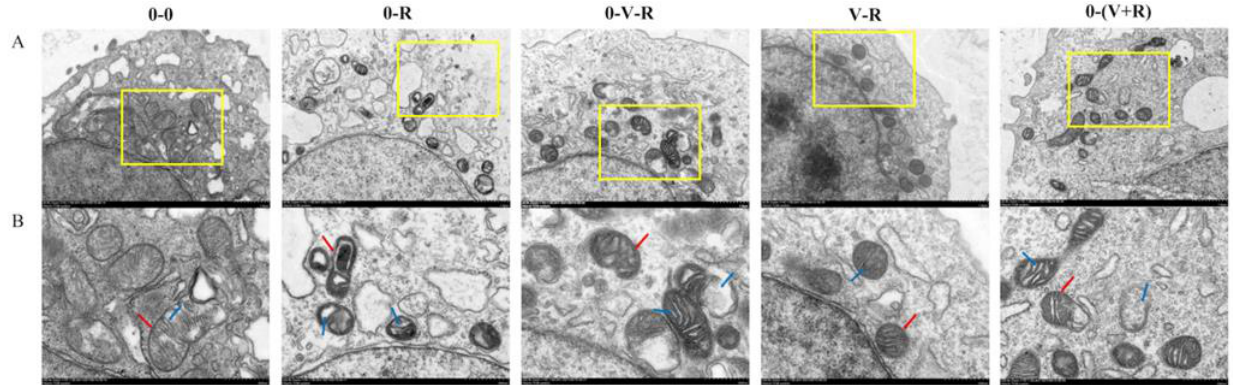
Figure 1. Effects of different incubation patterns of 1,25(OH) 2 D 3 on morphological changes of ZFL mitochondria after being treated with 3 µ M RSL3 for 6 h. Each group has two pictures, where picture ( B ) is an enlarged view of the yellow box area in picture ( A ), and the scale is marked on the bottom right of each picture. In ( B ), the red arrow indicates the mitochondrial membrane and the blue arrow indicates the cristae.